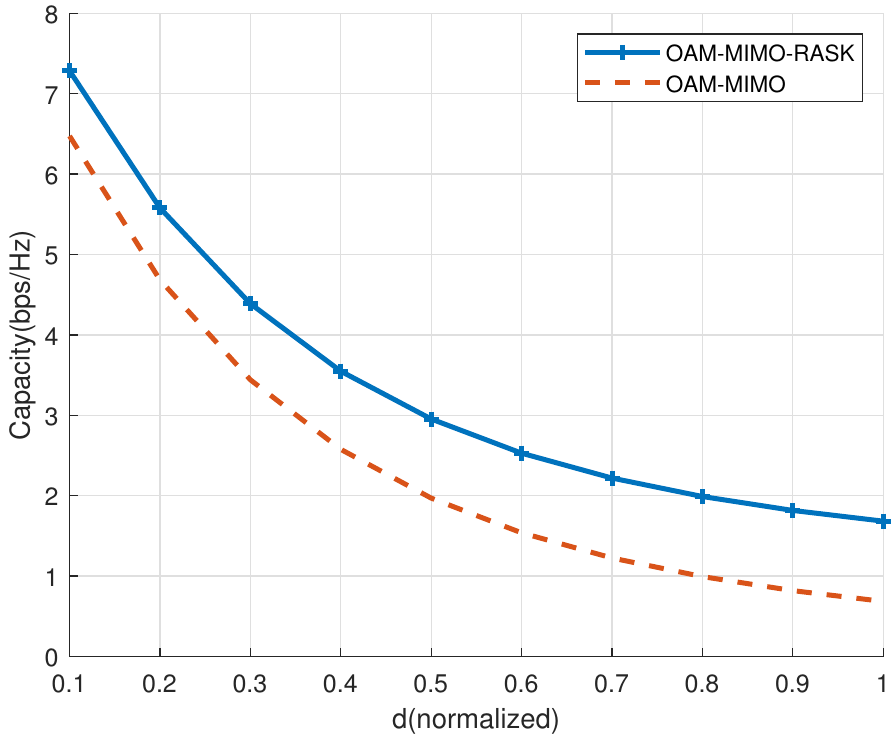
Figure 3. SC comparison between OAM-MIMO-RASK and OAM-MIMO with respect to normalized distance ( d